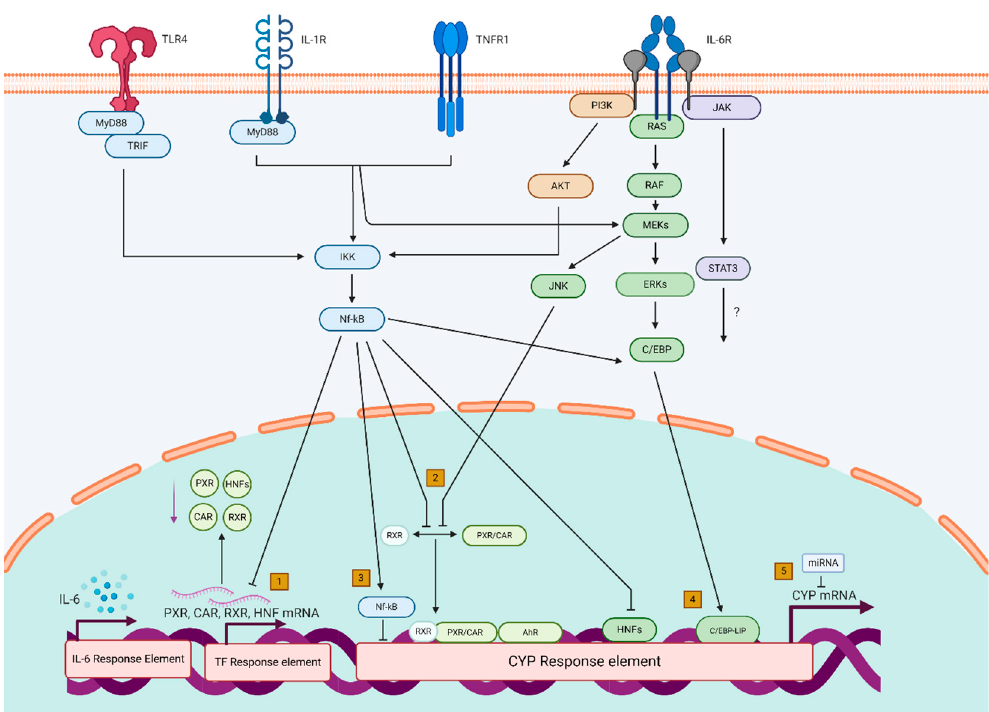
Figure 1. Mechanistic insights into the e ff ects of inflammation on CYP expression and activity. Transcriptional repression of important CYP enzymes during inflammation may proceed through (1) transcriptional downregulation of nuclear receptors and other transcription factors, (2) interference with dimerization / translocation of nuclear transcription factors, (3) altered liver-enriched C / EBP signaling, (4) direct regulation by NF- κ B, or (5) posttranscriptional